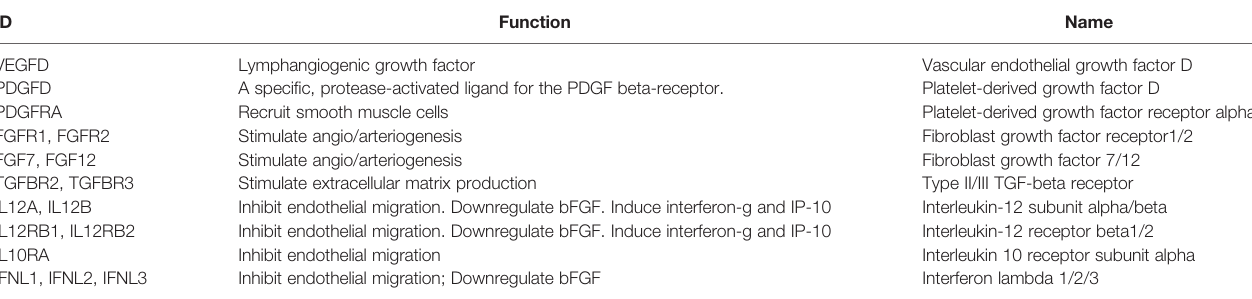
TABLE 3 | The list of angiogenic factors and inhibitors.